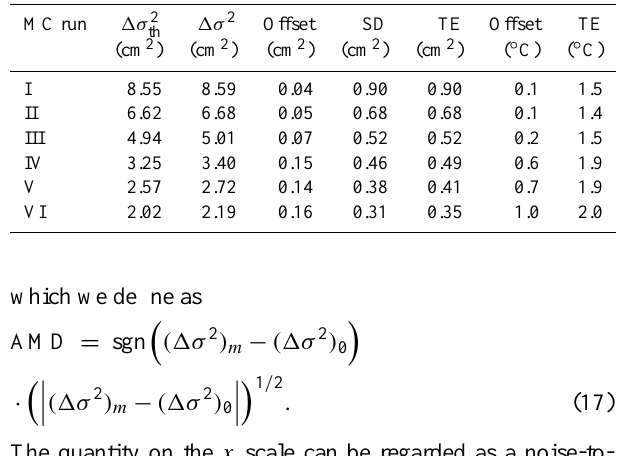
Figure 6. The mean and SD of the differential diffusion length of the 4000 data sets of Monte Carlo run I as a function of the uncer- tainty in the isotopic measurement are depicted in the top figures. The uncertainty is given as the SD of a Gaussian distribution centred around zero from which random numbers are drawn. The figure on the bottom shows the absolute measurement deviation (as described in the main text) for two different sampling resolutions. The data points given here are obtained from all six Monte Carlo runs and for several assigned values for the uncertainty in the δ 2 H measure- ment. The solid lines represent linear regressions to the data points which can be used to correct (cid:49)σ 2 for the deviation that arises as a result of measurement uncertainty.